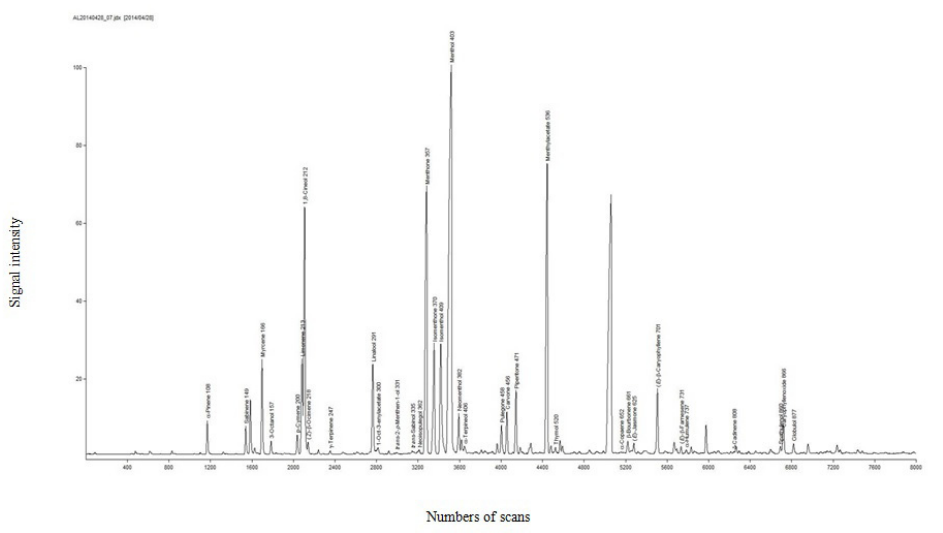
Figure 1: GC-MS chromatogram of M. piperita var. Perpeta essential oil.